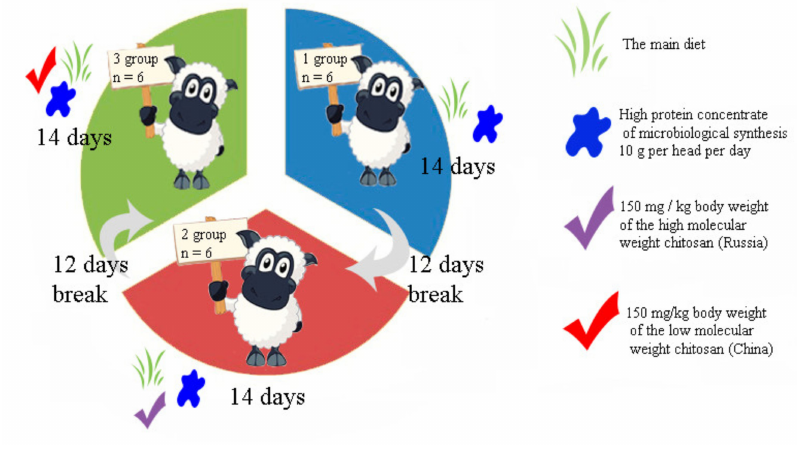
Figure 1. Schematic drawing of the experiments on six rumen-fistulated